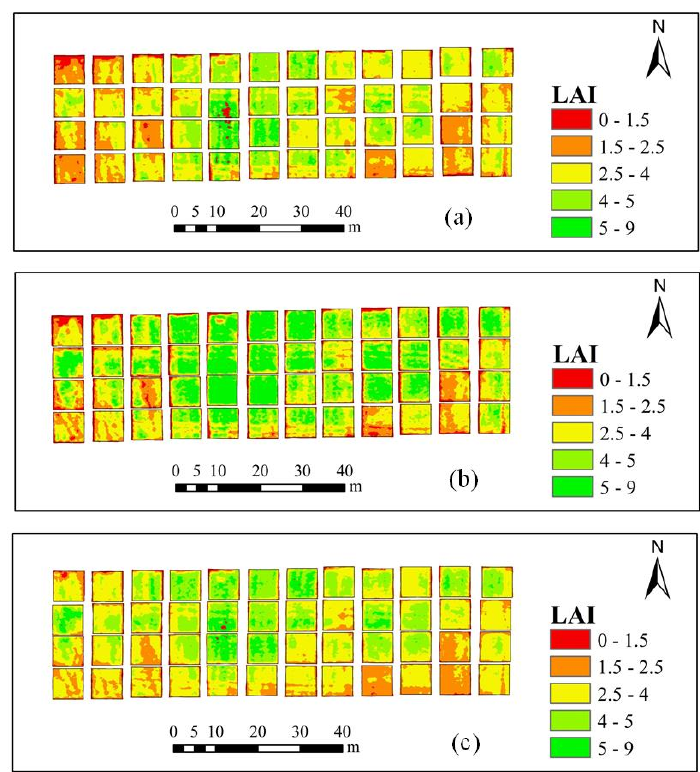
flagging stage; ( c ) flowering stage.